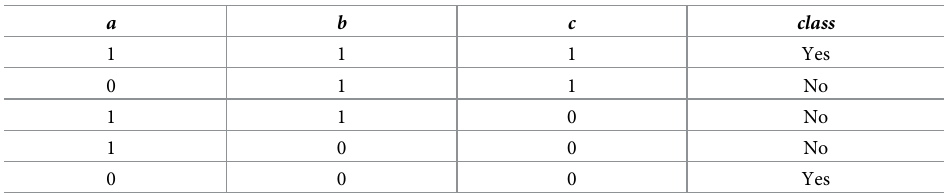
Table 1. Example of a simple decision